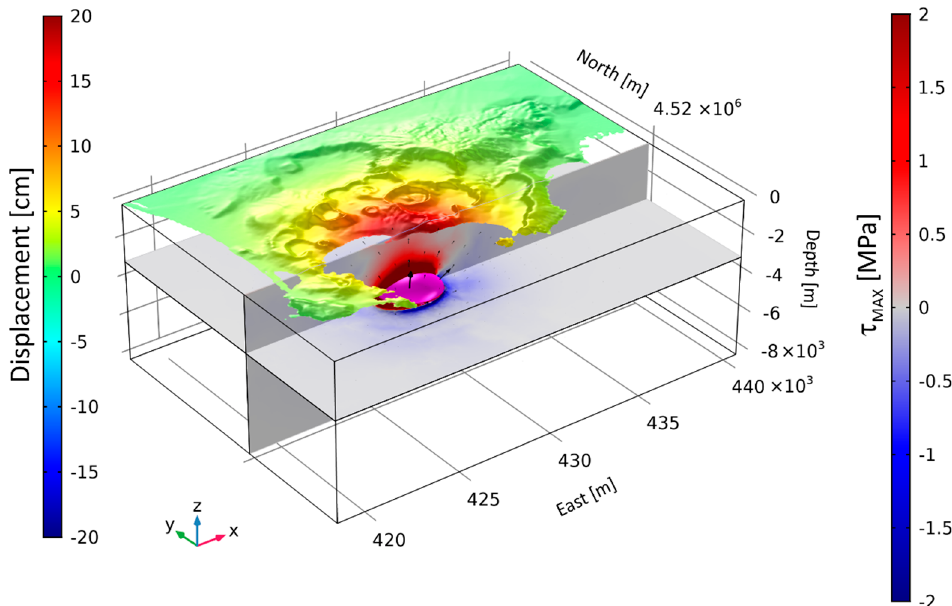
Figure 9. Time-dependent FE model results. Three-dimensional view of the modeled τ MAX at the end of 2013: horizontal slice at depth of 2500 m b.s.l. and vertical slice at N = 4520 km. On the top, the displacement field is superimposed on the SRTM shaded relief map of the CF caldera. The black arrows represent the displacement field; the magenta isosurface represents the inflating deformed source.